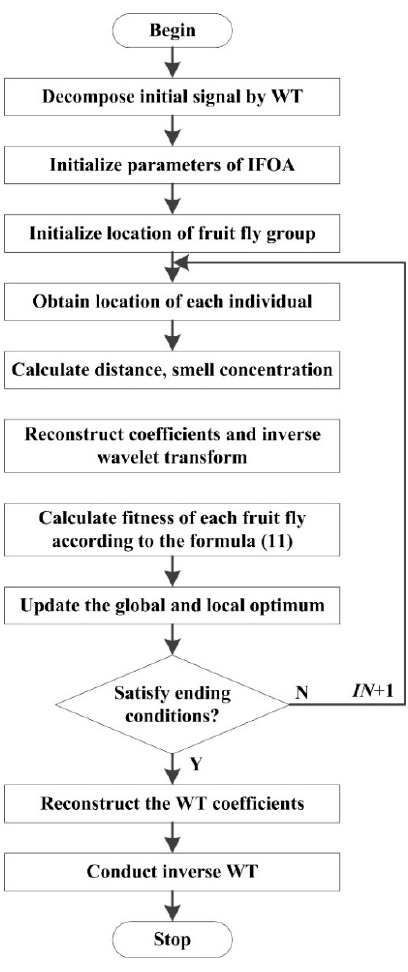
Figure 4. Process of the proposed denoising method.